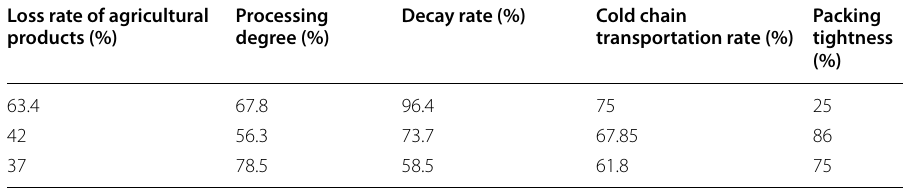
Table 1 A comparative study of developed countries and China Loss rate of agricultural products